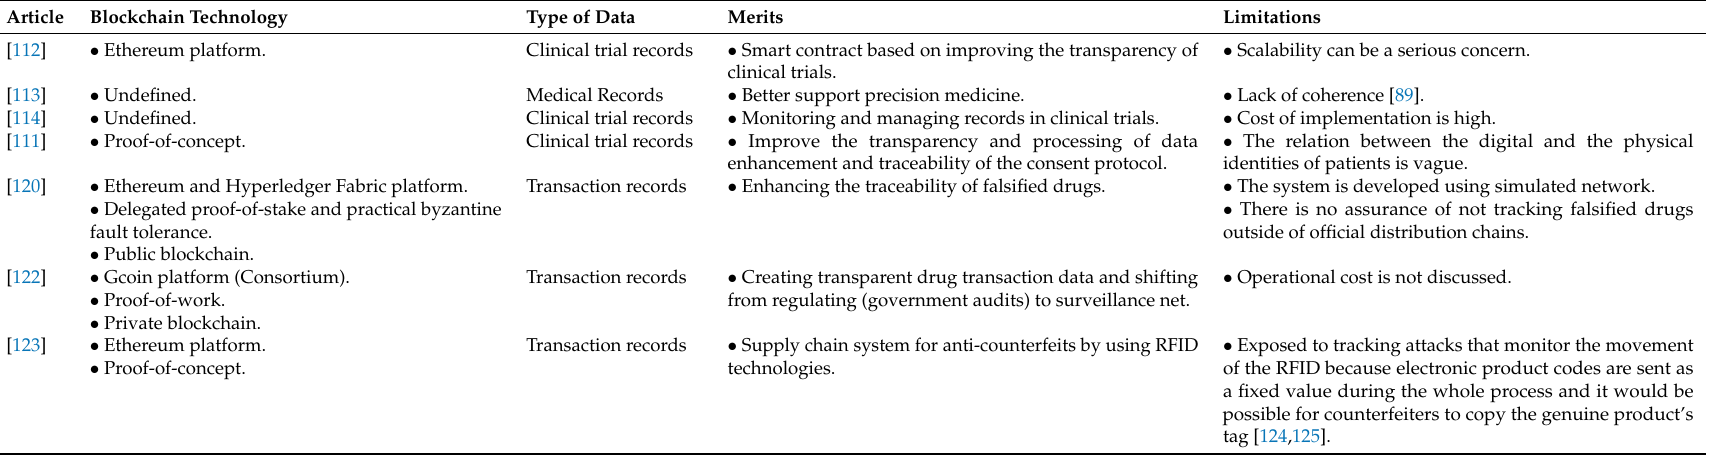
Table 2. Comparison of the supply chain management mechanisms for healthcare in the